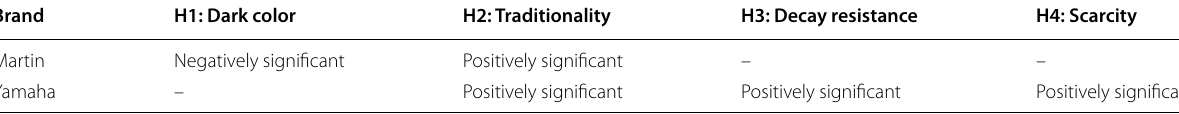
Table 9 Results of stepwise method for both brands (Analysis 2)